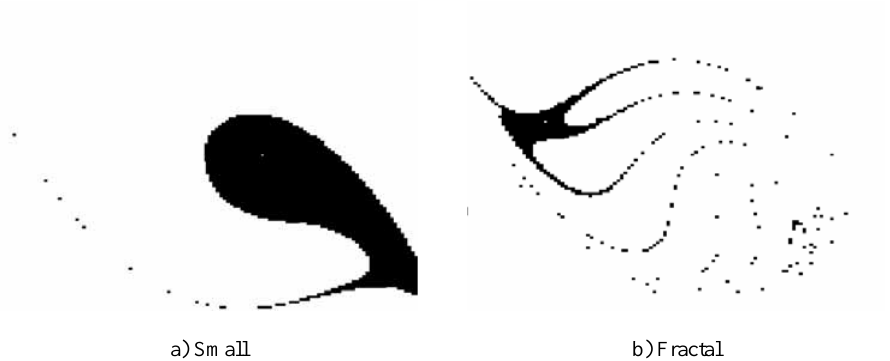
Fig. 7. Possible configurations of the basin of attraction close to the escape